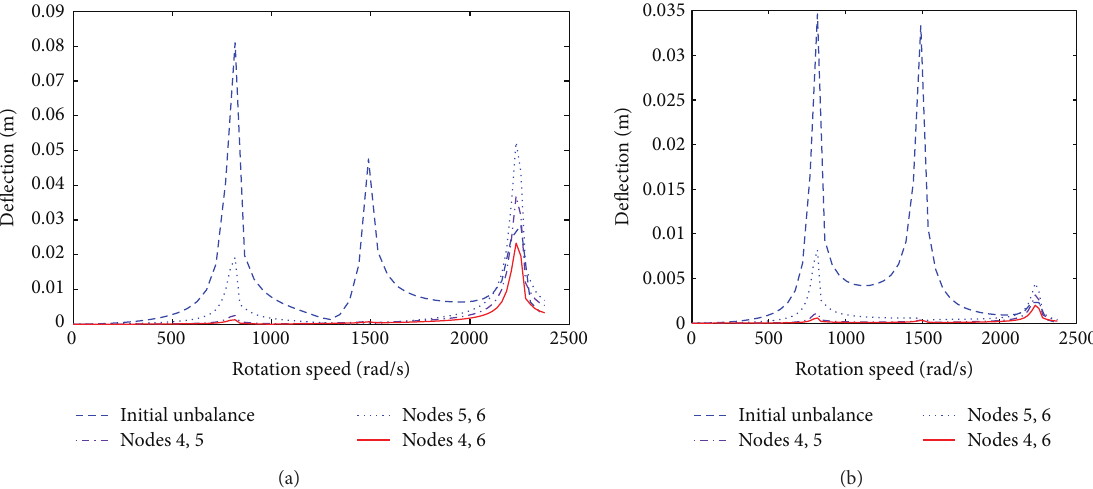
Figure 7: Transientdeflection responseversus speed ofrotation with balancing (—)and without correction mass (---): (a)node4, (b)turbine disk 1, node 7.